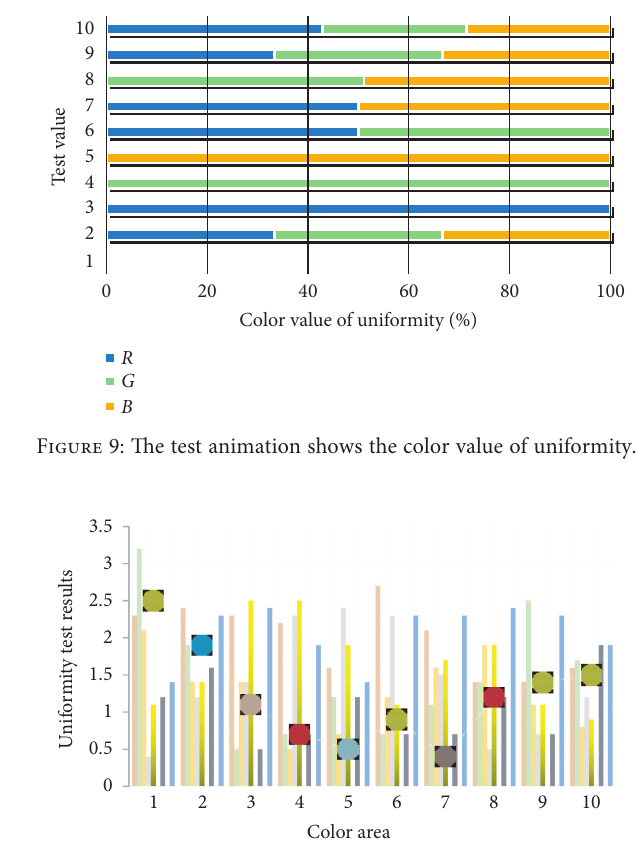
Figure 10: Animation showing uniformity test